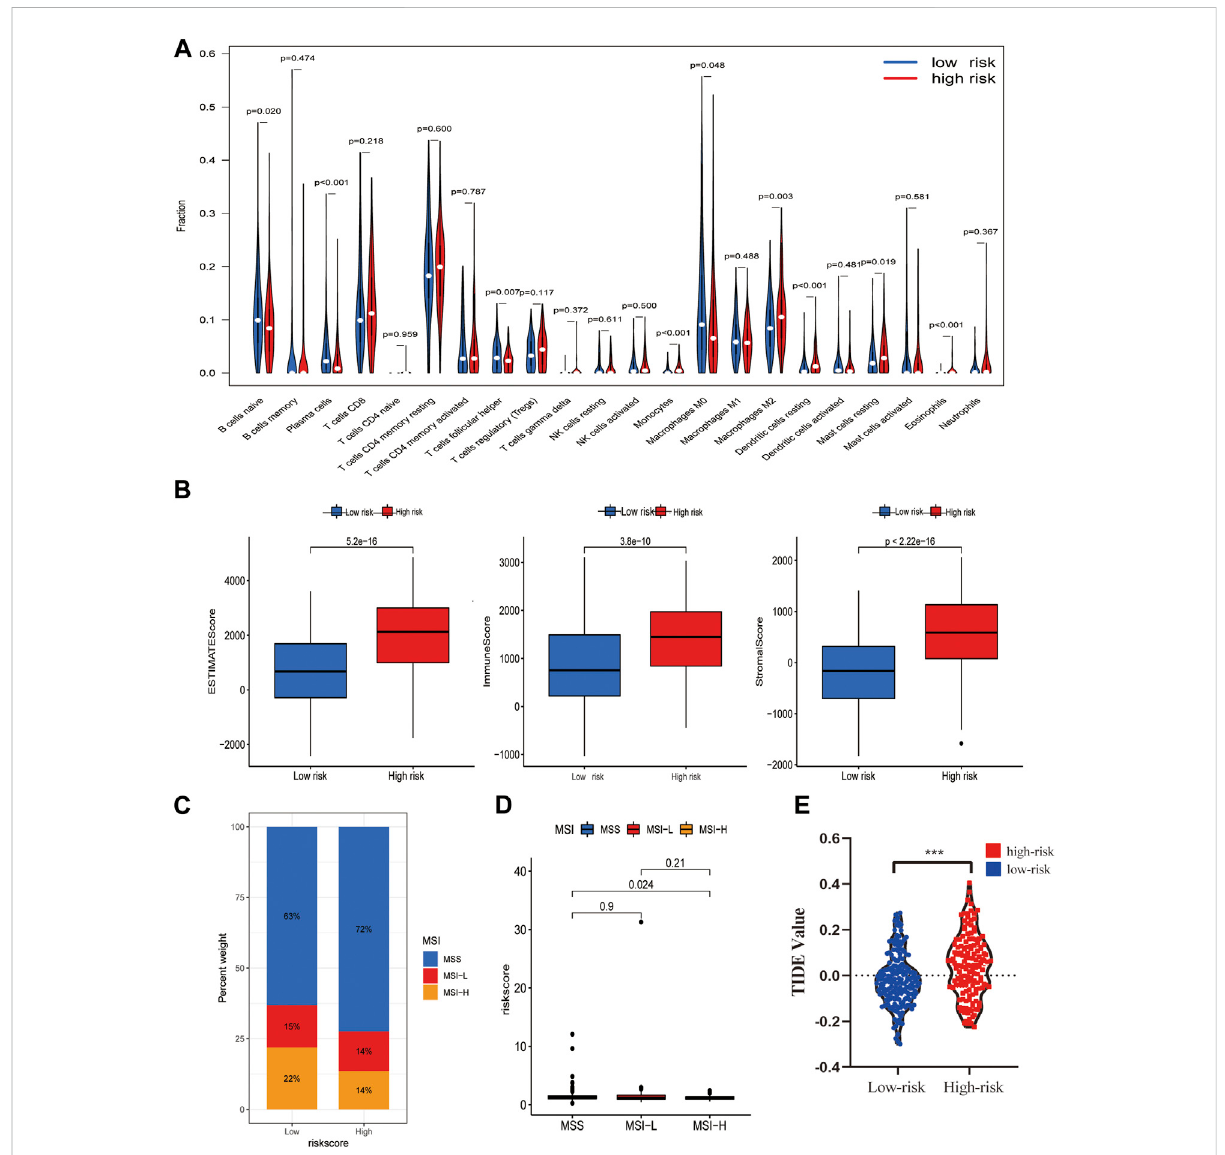
FIGURE 6 Potential role of therisk model in theTME and immunotherapy. (A) The content of22 immunecells betweenthe high- and low-risk groups. (B) TME Estimate-Scores, Immunity-Scores, and Stromal-Scores measured between high- and low-risk groups. (C , D) Differences in microsatellite instability (MSI) between patients in the high- and low-risk groups. (E) Differences in immunotherapy scores between high- and low-risk